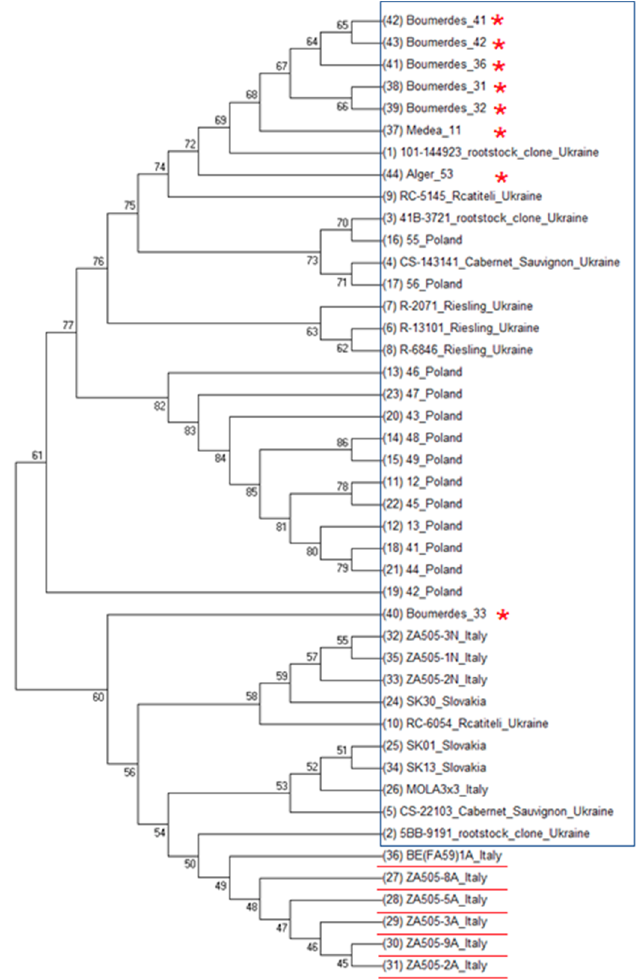
Figure 2. Molecular phylogenetic analysis of the RdRp domain sequences using the maximum likelihood method based on the Tamura–Nei model [29]. Algerian GPGV isolates and the isolates determined to be symptomatic and asymptomatic were included [2,3,24]. The isolates in the box did not cause typical GPGV symptoms. The cladogram was constructed using MEGA 7 [30], Muscle [31] and the UPGMB clustering method. Node IDs (sorting of the sequences) corresponded to the tabular description of the timetree in the text editor. All isolate sequences and individual nodes had IDs (see Supplementary Material Table S1). The isolates in the box did not cause typical grapevine leaf mottling and deformation (GLMD) symptoms, the isolates highlighted by red asterisks were obtained in this study, and the underlined isolates caused GLMD